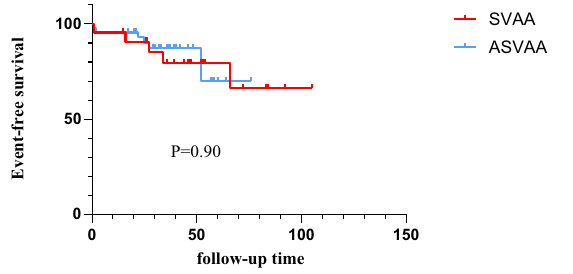
Figure 5. Kaplan–Meier analysis for event-free survival for symptomatic visceral artery aneurysm (SVAA) and asymptomatic visceral artery aneurysm (ASVAA) during